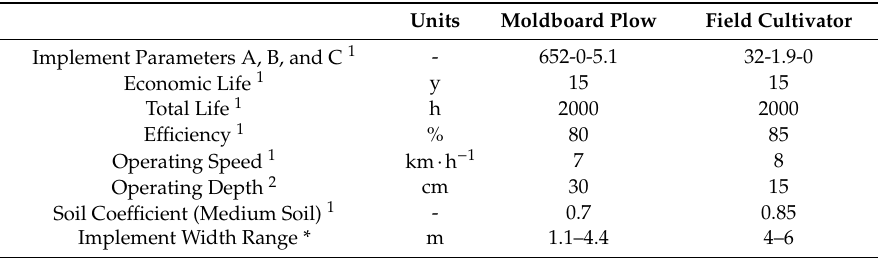
Table 1. Operation input parameters.